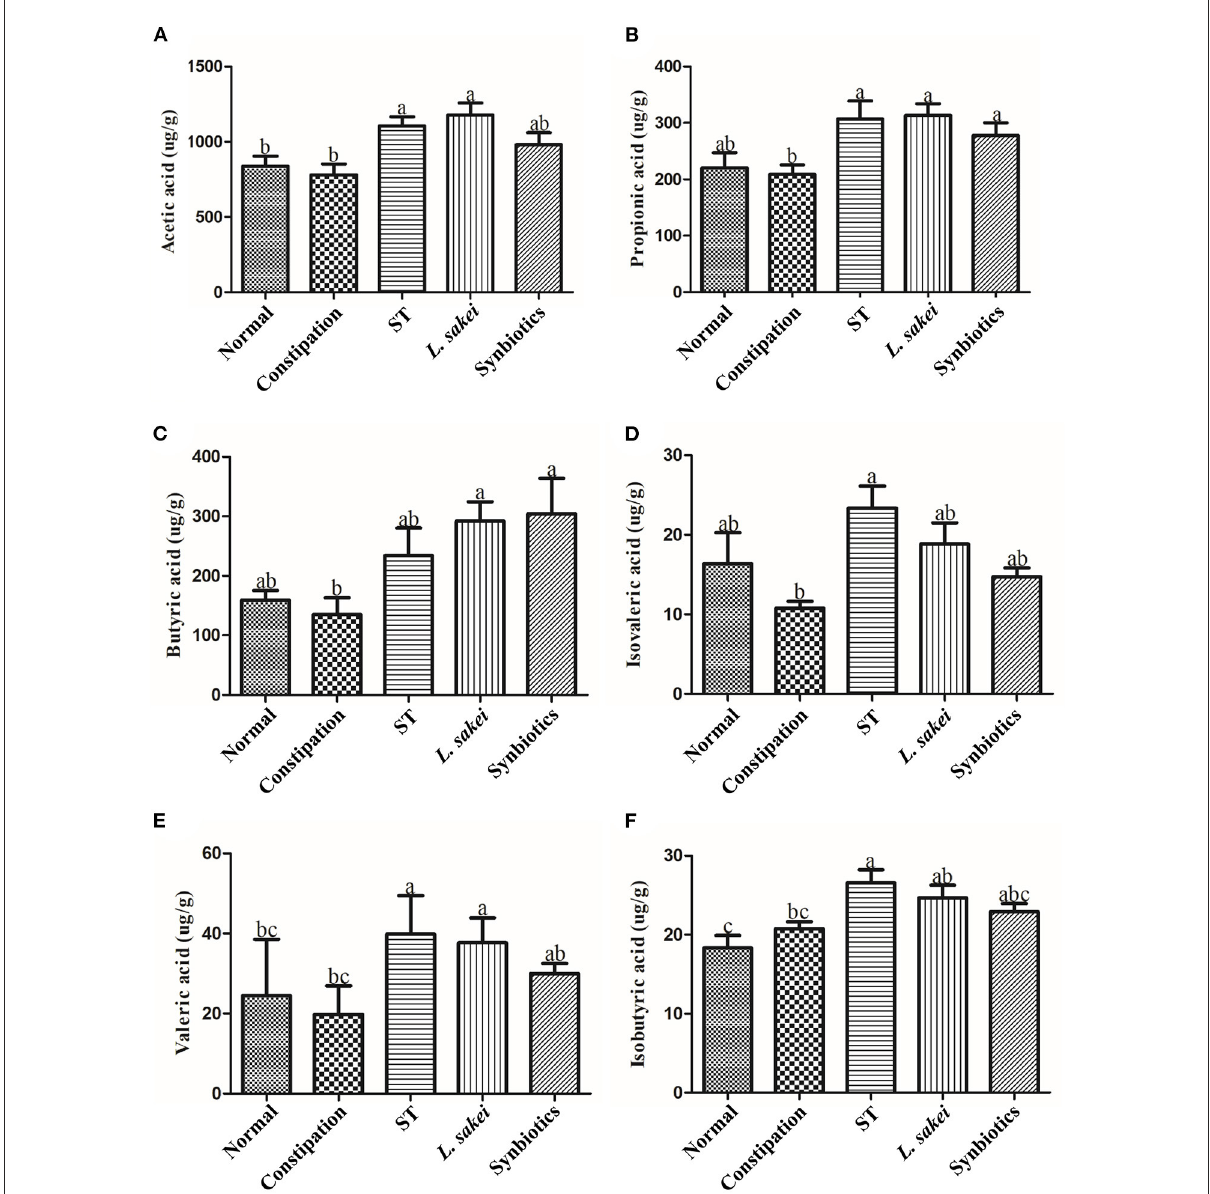
FIGURE5 The effect of ST or L. sakei alone or combined on short-chain fatty acid levels of constipation-related intestinal factors in mice. (A) Acetic acid; (B) Propionic acid; (C) Butyric acid; (D) Isovaleric acid; (E) Isobutyric acid; (F) Valeric acid. Data represent the mean ± SD ( n = 6). Statistical analysis was conducted using one-way ANOVA followed by Tukey’s multiple comparisons test for each group. Bars bearing different letters indicate a significant difference, P <